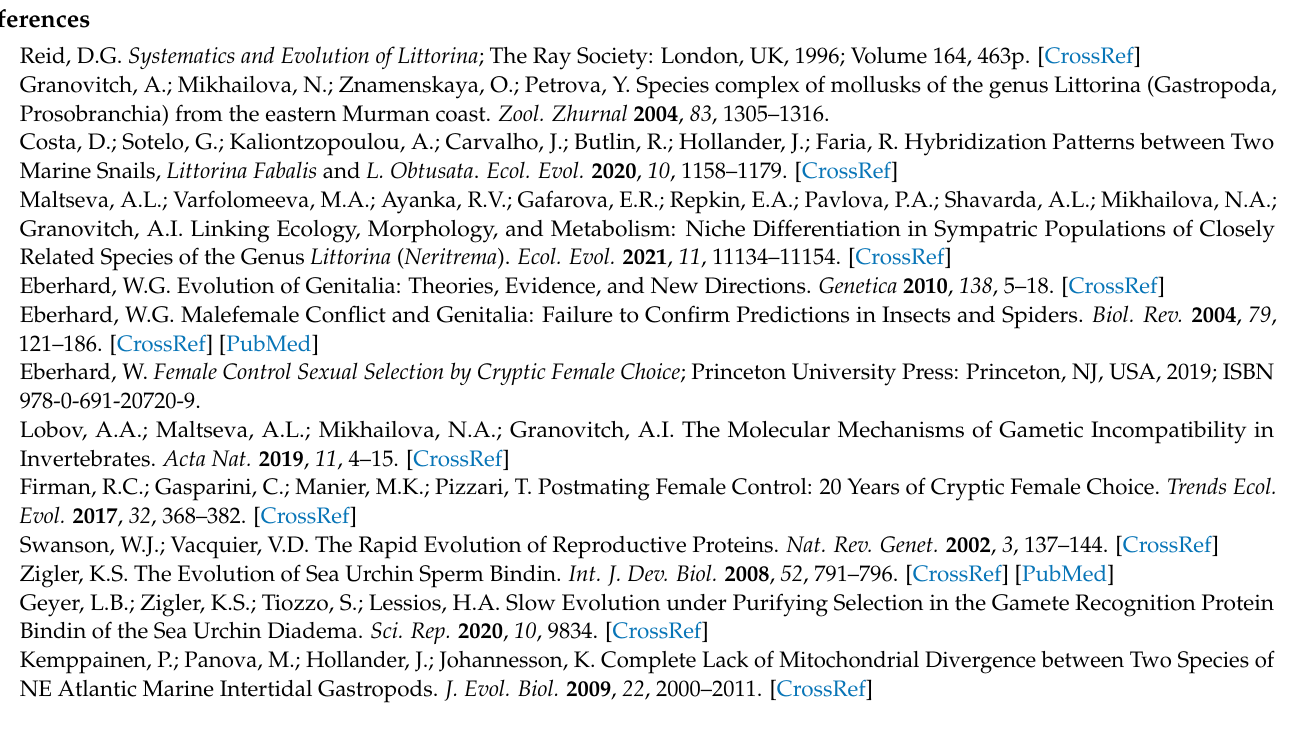
Figure S1: Comparison of the results of calreticulin identification using the UniProt database and L. fabalis or L. obtusata pallial oviduct transcriptomes de novo assembles; Figure S2: Comparison of the results of aldolase and arginine-kinase identification using L. fabalis or L. obtusata pallial oviduct transcriptomes de novo assembles; Figure S3: Comparison of the results of the scavenger receptor cysteine-rich domain-contained oviduct protein (SRCR-OP) and uncharacterized protein identification using L. fabalis or L. obtusata pallial oviduct transcriptomes de novo assembles; Figure S4: Comparison of the results of Tachylectin-related protein (TRP) and Capsule gland specific secretory protein identification using L. fabalis or L. obtusata pallial oviduct transcriptomes de novo